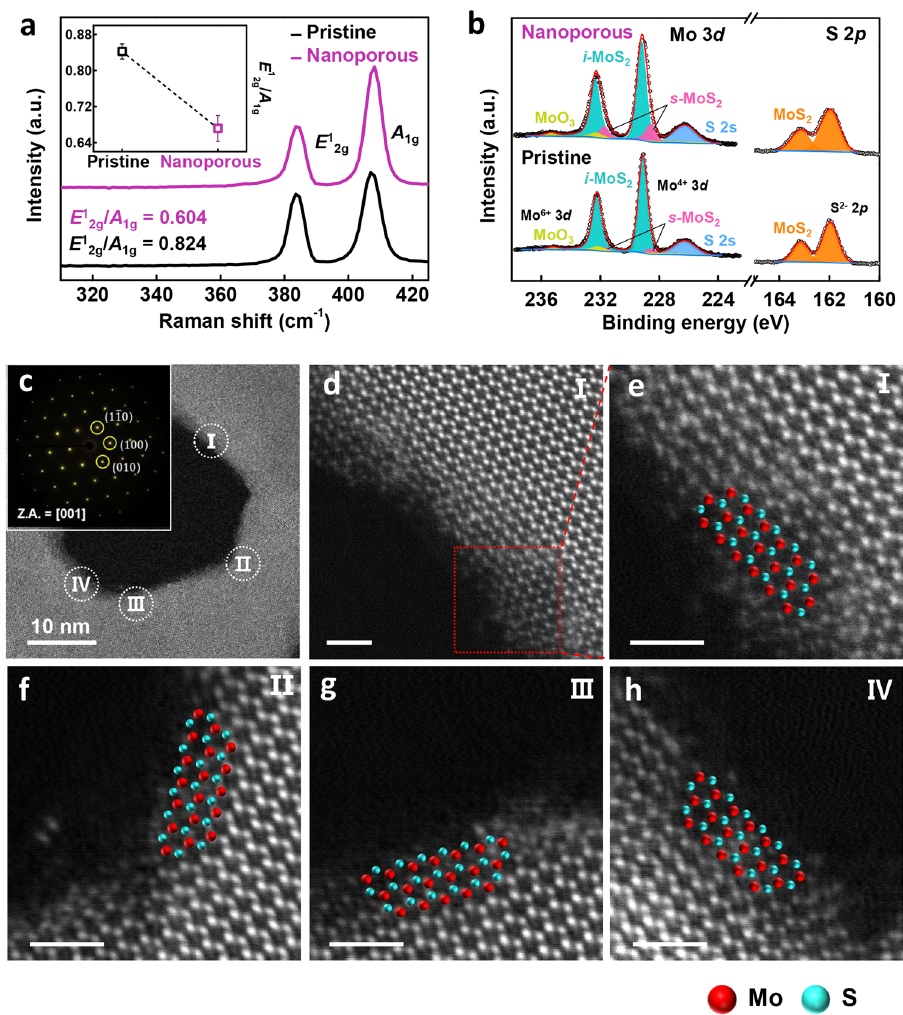
Fig. 2 Edge structure of the hexagonal nanohole in the multilayer nanoporous MoS 2 . a Raman and b XPS spectra of multilayer pristine and nanoporous MoS 2 , respectively. c , ADF-STEM image of a typical hexagonal nanohole in the nanoporous MoS 2 (inset is SADP exhibiting a typical 2H-MoS 2 structure). d – h Atomic-scale ADF-STEM observations of the four regions denoted by I, II, III, and IV in c (scale bars of 1